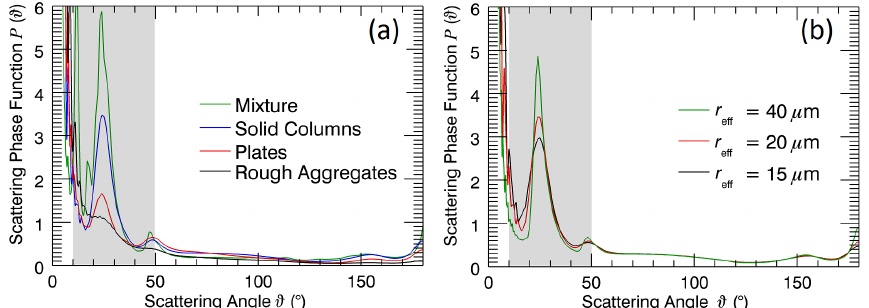
Fig. 9. Scattering phase functions for (a) the different ice crystal shapes at 20µm and (b) solid columns, calculated for the three effective Fig.9: Scatteringphasefunctionsfor (a) thedifferenticecrystalshapesat20 µ mand (b) solidcolumns, calculatedforthethree radii for the retrieval in this study. The grey bar indicates the captured scattering angle range during the effectiveradiitotheretrievalforthisstudy. Thegreybarindicatesthecapturedscatteringanglerangeduringthemeasurements.